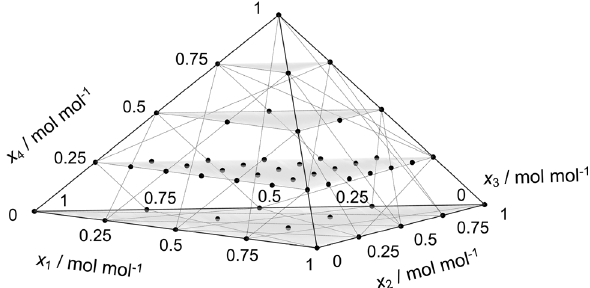
Figure 1. Studied compositions (bullets) of the quaternary mixture water (1) + methanol (2) + ethanol (3) + 2-propanol (4) as well as its ternary and binary